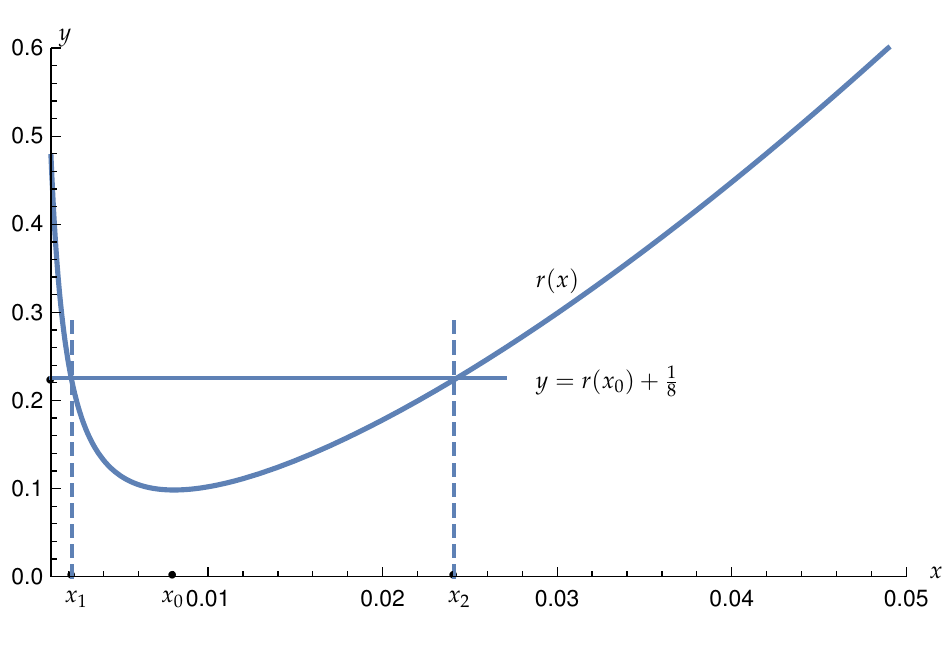
Figure 1. Graph of the function r ( x ) from Example 2. Points x 1 = f − 1 ( 1/8 ) = 0.00218 and x 2 = g − 1 ( 1/8 ) = 0.024 are indicated.